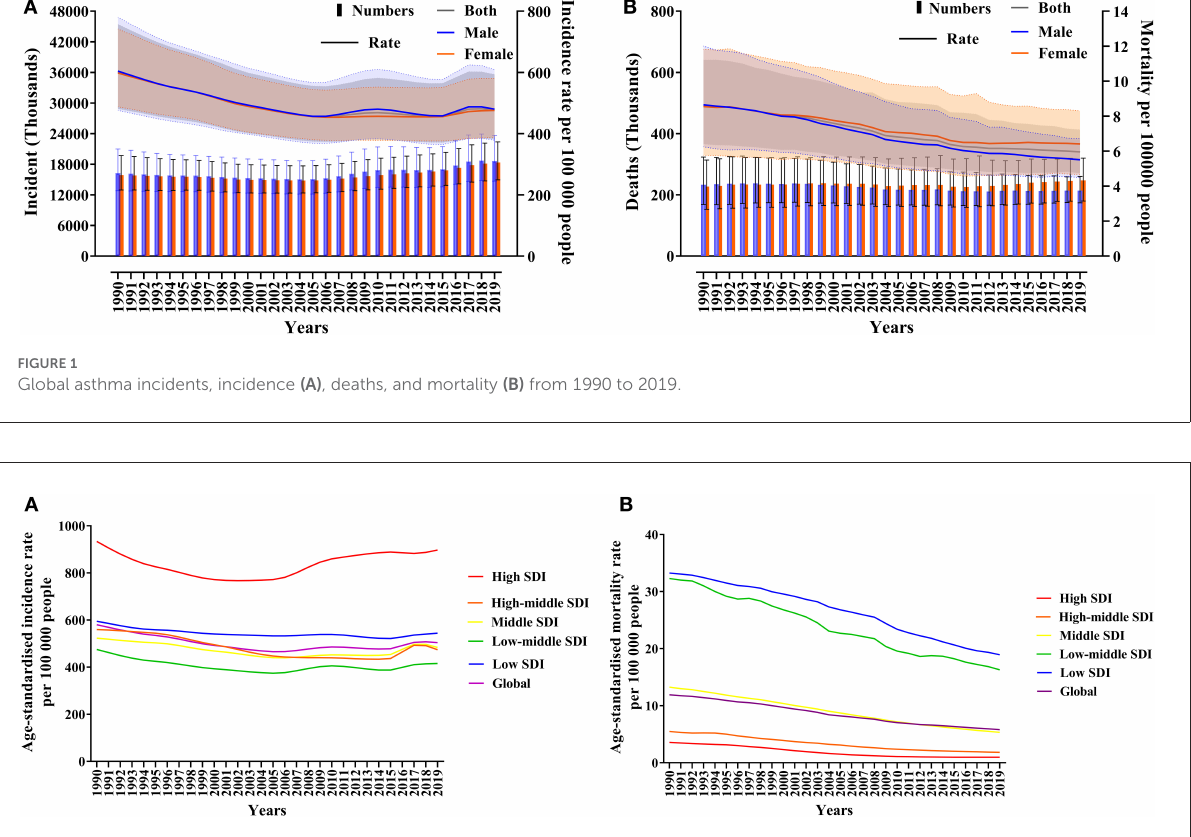
FIGURE2 Global age-standardised incidence rate (A) and age-standardised mortality rate (B) of asthma by SDI regions, 1990 to